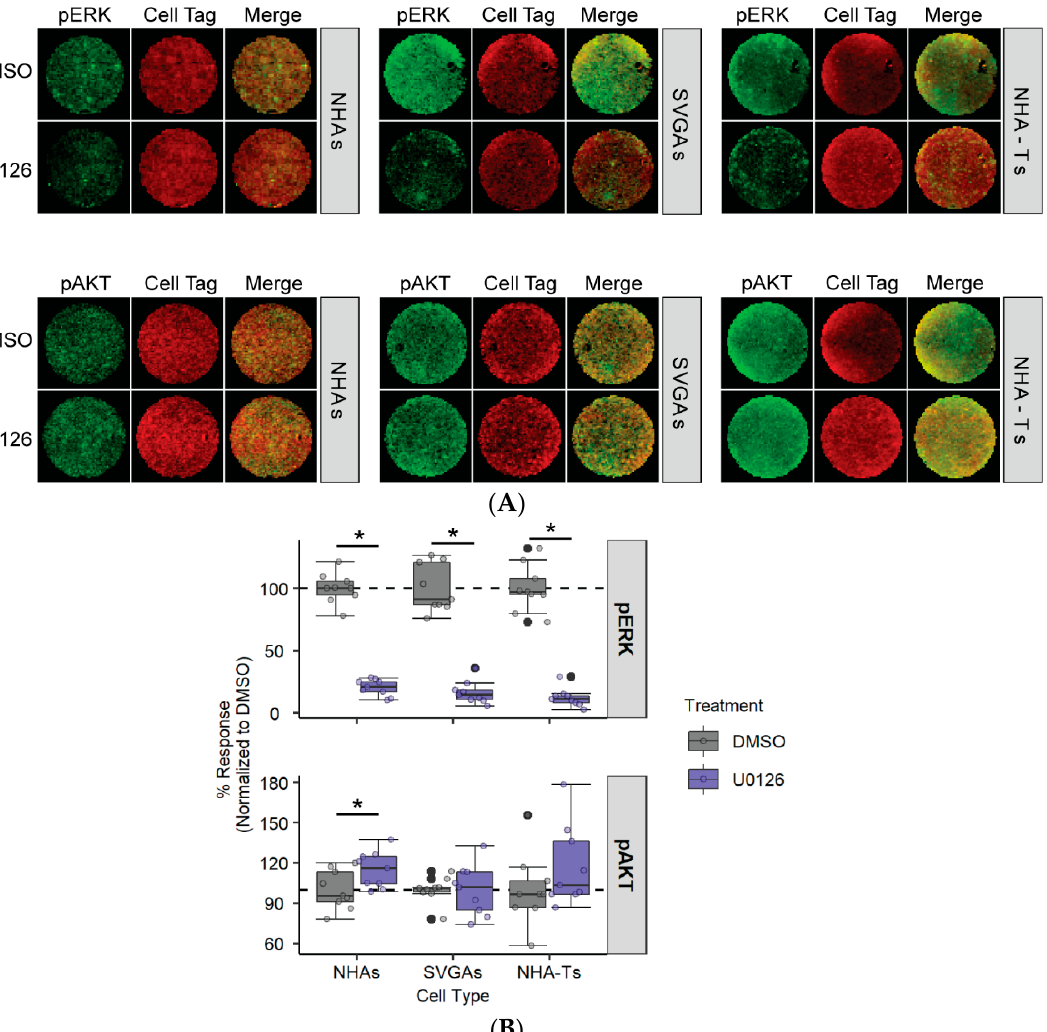
Figure 2. U0126 increases AKT phosphorylation in NHAs. ( A ) NHAs, SVGAs, and NHA-Ts were treated with DMSO or U0126 (10 µ M) at 37 ◦ C for 24 h. Cells were fixed and stained for pERK or pAKT (green) or CellTag (red). Entire wells of a 96-well plate are shown ( B ) Percentage of pERK and pAKT for each cell type was quantitated by ICW signal intensity values per [(pERK or pAKT)/Cell Tag × 100% = % response] within each ICW analysis with LI-COR software. Box and whisker plots represent the distribution of samples (individual points), with the lower quartile, median and upper quartile denoted as black lines. Colored points represent individual points for each cell type (3 replicates, performed in triplicate), and outliers are represented by black circles. The dashed line indicates the normalized DMSO % response of pERK and pAKT. A Wilcoxon rank sum exact test was used to compare treatments in each cell type. Data are representative of three independent experiments performed in triplicate. *, p <